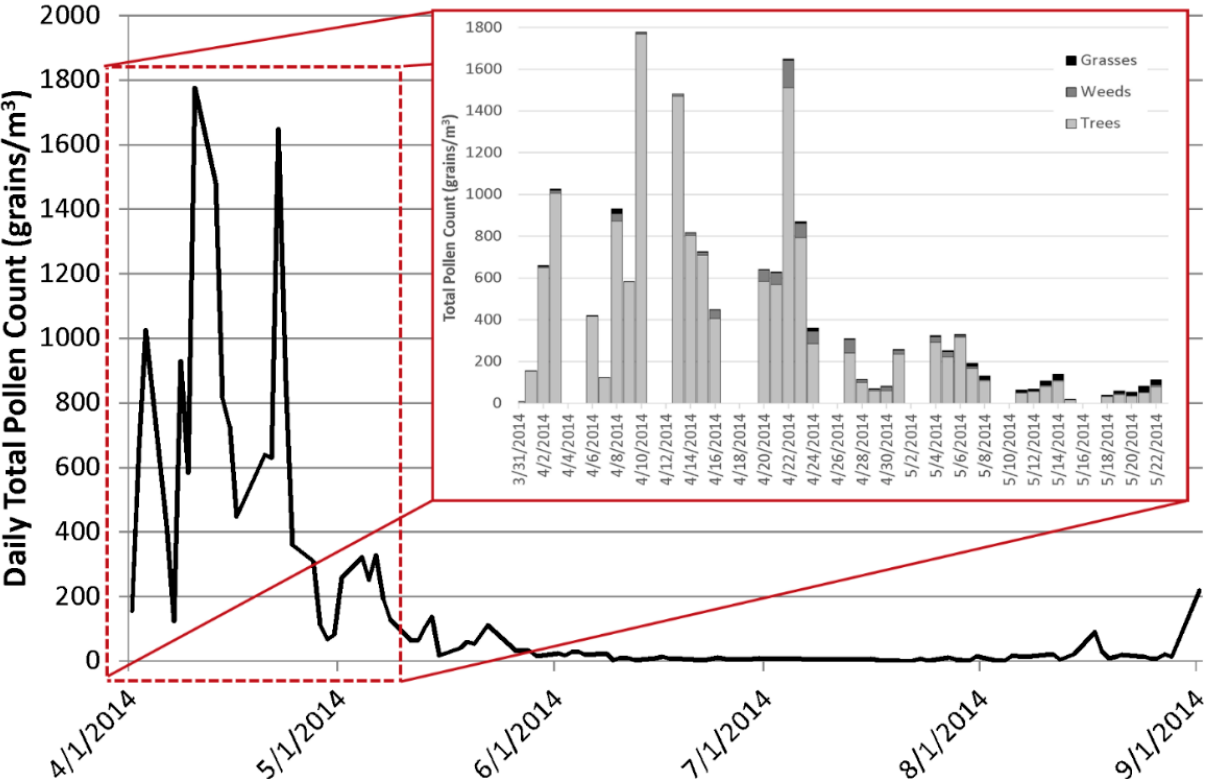
Figure 2. Daily total pollen count for Raleigh, NC and the relative contribution of weeds, grasses, and trees to the total pollen count during the peak pollen period (inset).